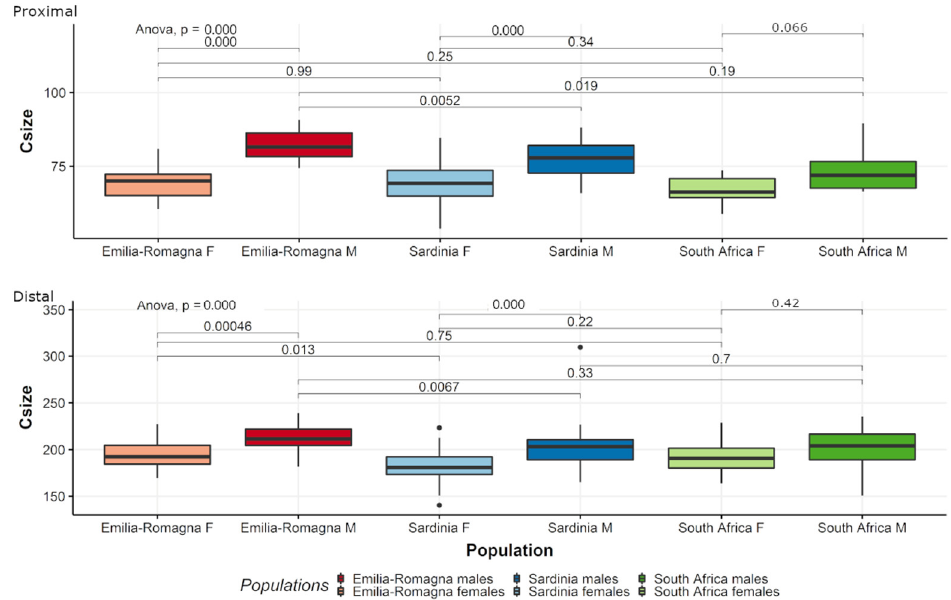
Figure 9. Box plot of centroid size (Csize) of proximal ( above ) and distal ( below ) fibular epiphyses all populations by sex. M = males; F = females. Black lines are the medians, boxes represent the interquartile ranges, whiskers the non-outliers range, and filled circles the outliers.